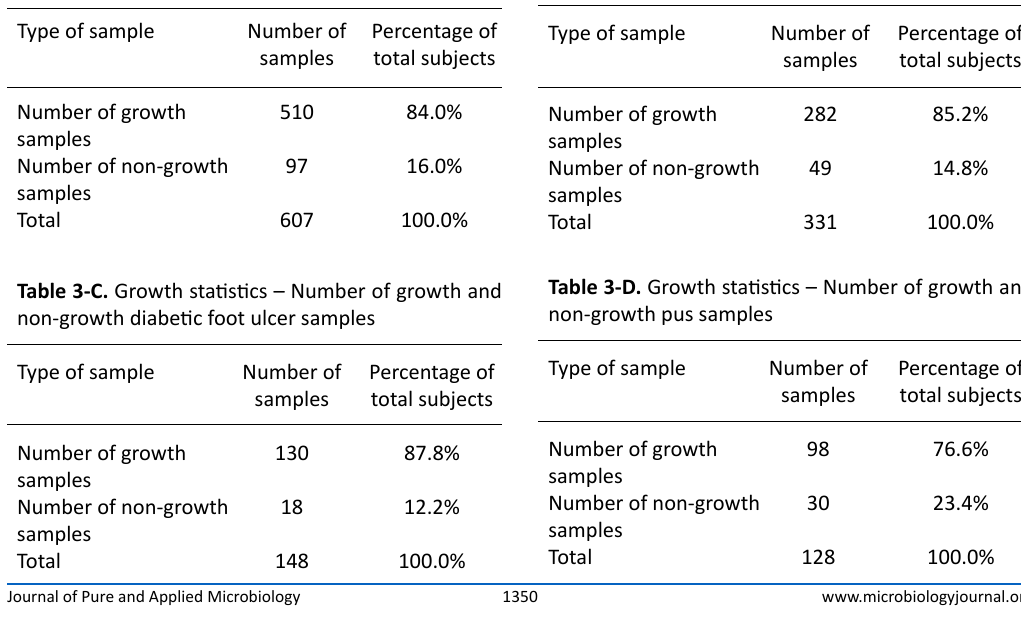
Table 3-B. Growth statistics – Number of growth and